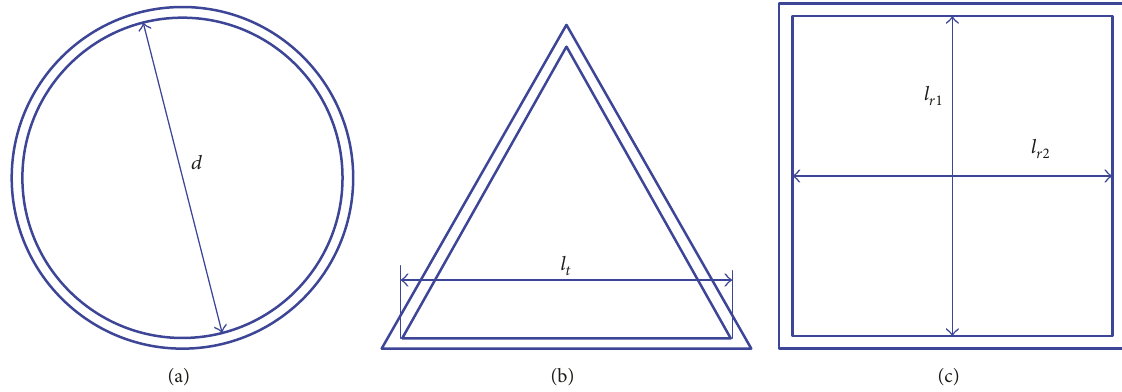
Figure 2: Cross-section of the container: (a) round, (b) triangle, and (c) rectangle.